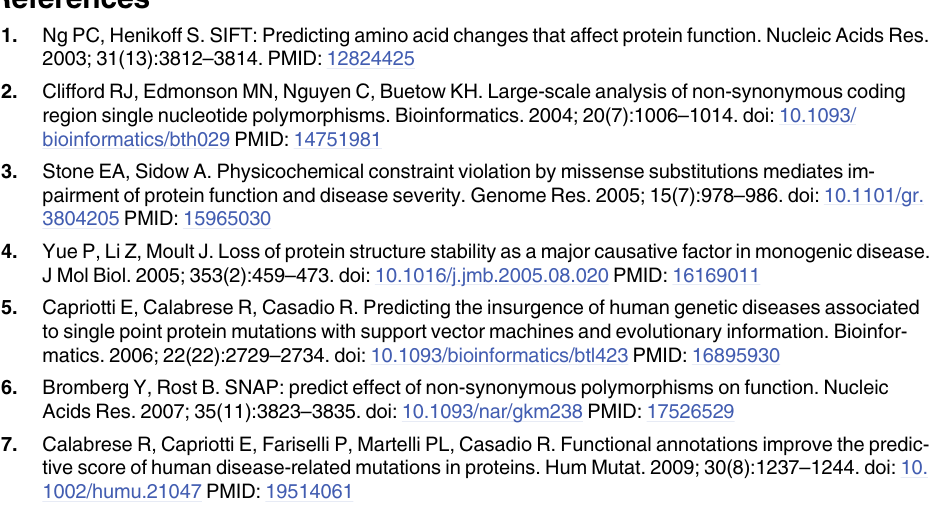
S2 Fig. Domain feature weights. Heat maps showing feature weights obtained from classifiers trained using the domain features. The rows show feature weights obtained per subset classifi- er. The single row at the bottom shows feature weights obtained from a classifier trained on the entire set of variants. Low (blue) and high (red) weights indicate that the feature is predictive for neutral and disease-associated variants respectively. S3 Fig. All feature weights. Heat maps showing feature weights obtained from classifiers trained using all features. The rows show feature weights obtained per subset classifier. Both the rows and the columns are hierarchically clustered (complete linkage). The single row at the bottom shows feature weights obtained from a classifier trained on the entire set of variants. Low (blue) and high (red) weights indicate that the feature is predictive for neutral and dis- ease-associated variants respectively. S4 Fig. Classifier performances using all features. a) Classifier performances using the entire data set. b) Classification performances per variant subset. S1 Table. AAIndex scales. The AAIndex amino acid scales with highest correlation ( r ) to the varimax-derived scales ( V ) as taken from [26]. S2 Table. Classifier